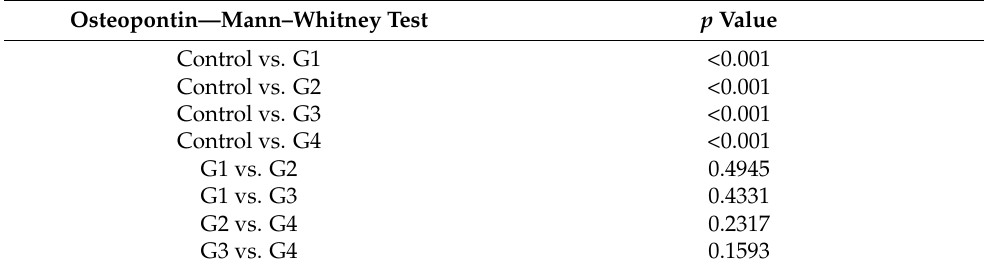
Table 3. Immunohistochemistry—analysis of results immunomarked sections with OPN—using